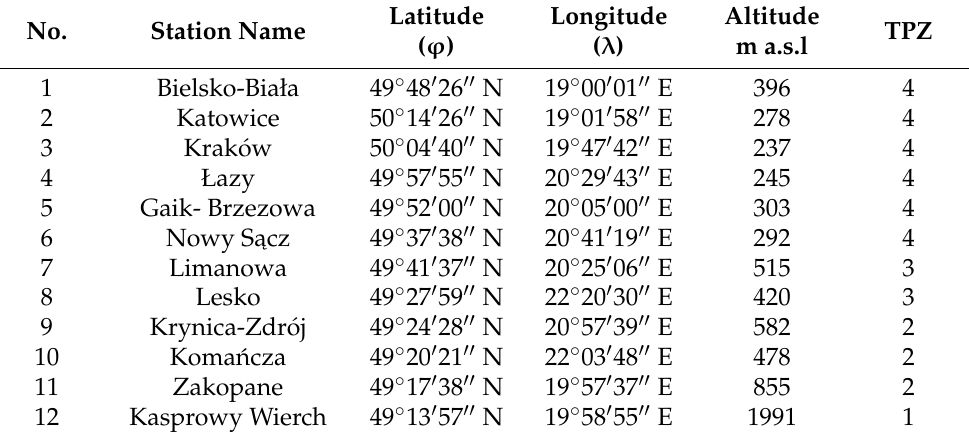
Figure 1. Location of the meteorological stations used in the study numbers as in Table 1. Table 1. Coordinates and altitude of the meteorological stations used in the study numbers as in Figure 1. TPZ concept is explained in Section